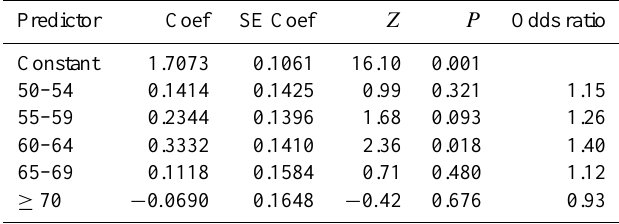
Predictor Coef SE Coef Z P Odds ratio Constant